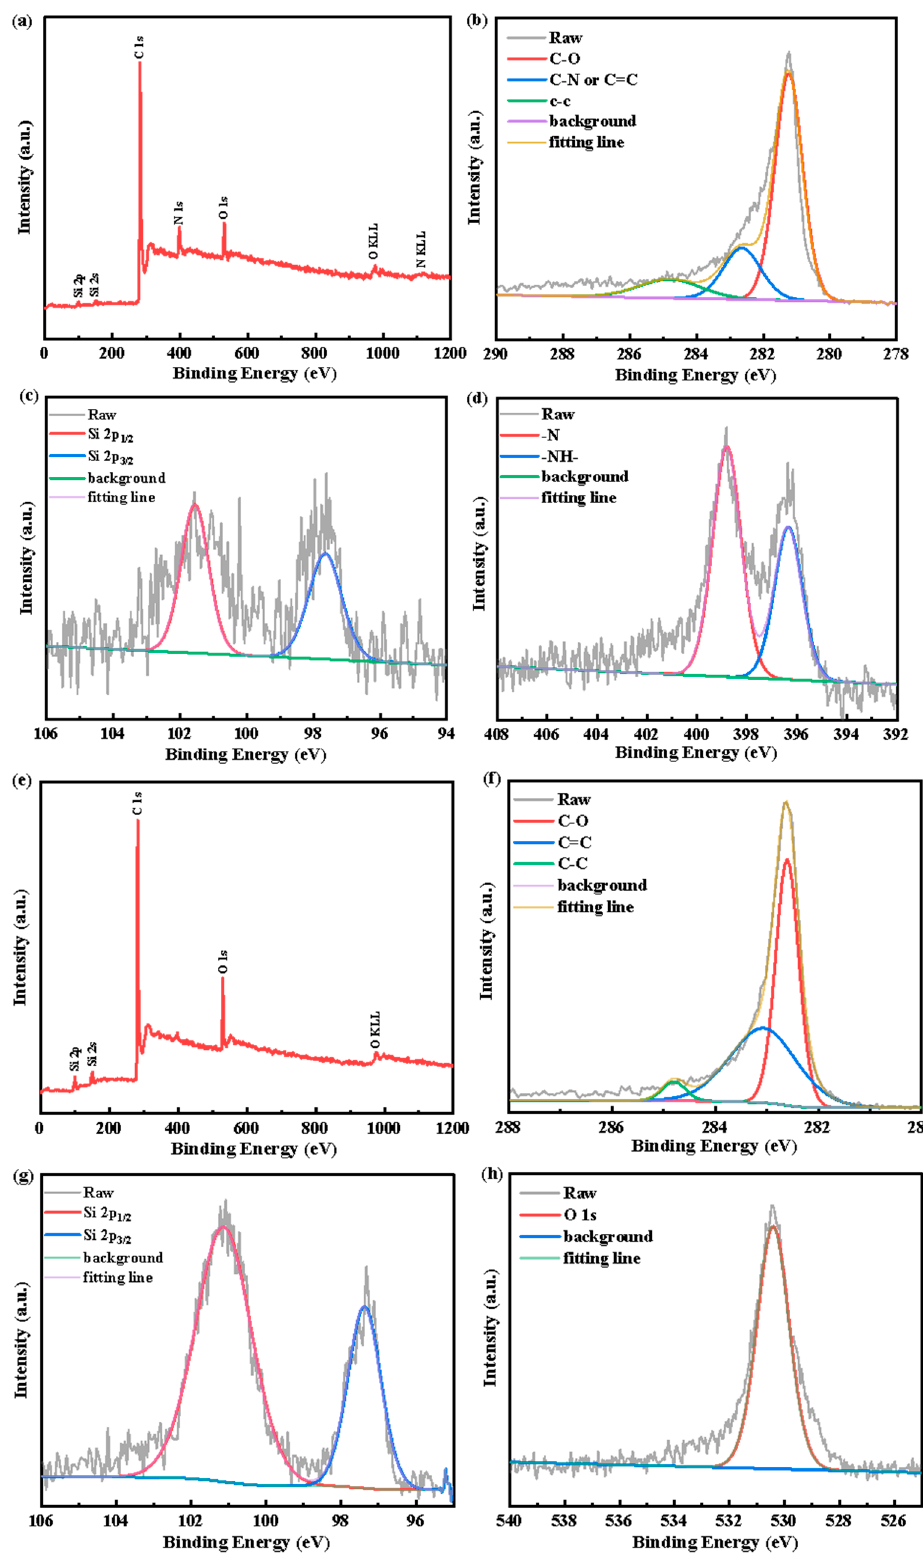
Figure 4. XPS spectra of the ( a ) Si@EG@p-PANI composite, ( b ) C1s signal, ( c ) Si2p signal, ( d ) N1s signal, ( e ) Si@EG composite, ( f ) Si2p signal, ( g ) C1s signal and ( h ) O1s signal.